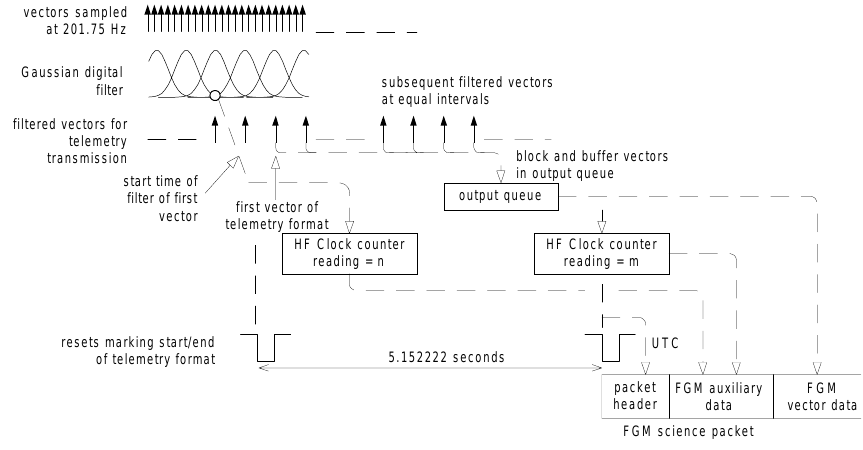
Fig. 3. Internal generation of the timing data for transmission though the spacecraft telemetry to ensure the accurate reconstruction of the vector timing by the ground